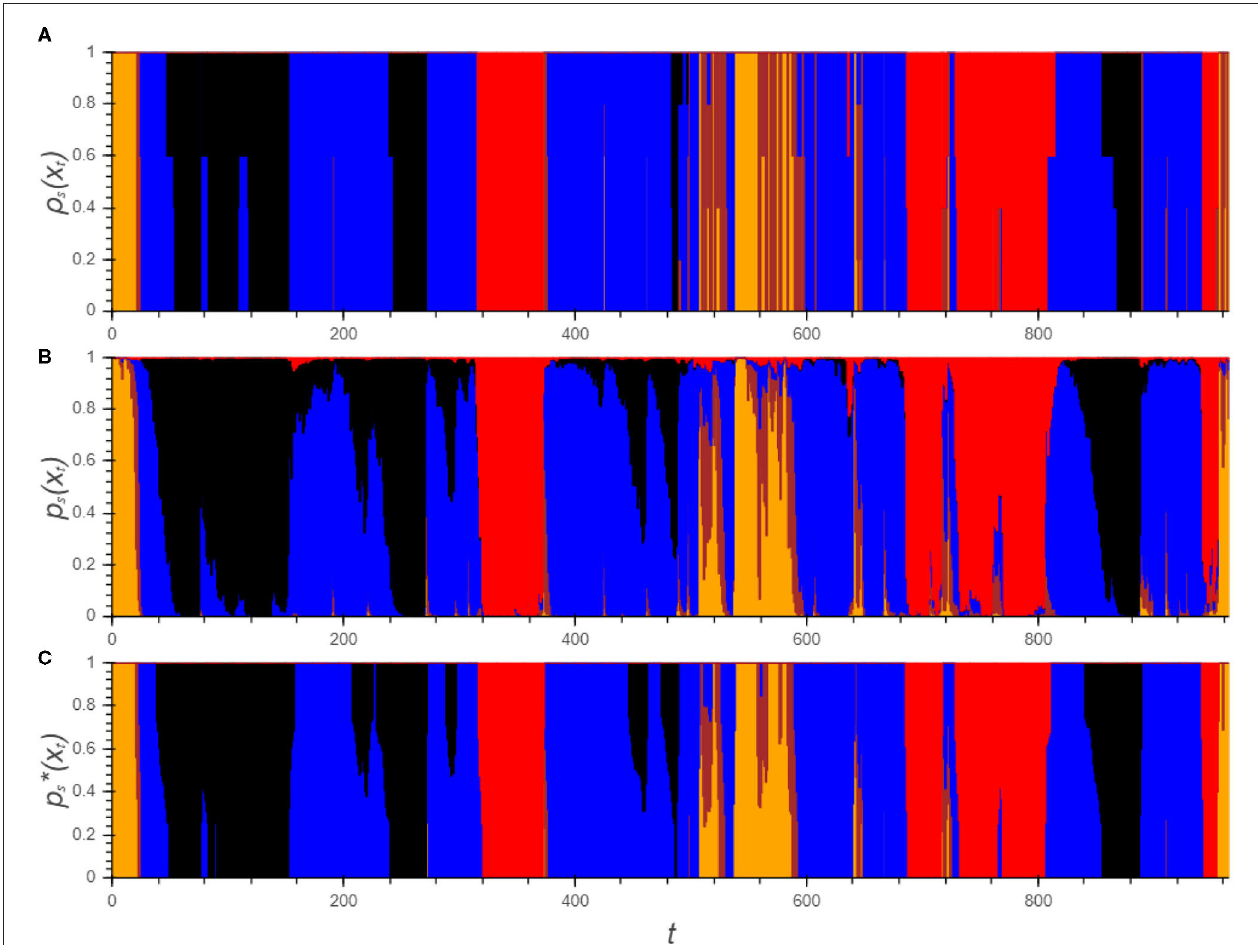
FIGURE 3 | Hypnodensity graphs showing the experts’ labels (A) as well as the algorithm’s posterior class probabilities before (B) and after the transformations (C) . Each color represents a sleep stage (W: yellow, N1: brown, N2: blue, N3: black, R: red).